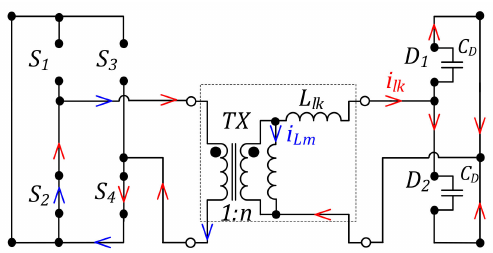
Figure 3. Equivalent circuit describing the parasitic oscillations in the SRC for the SPWM